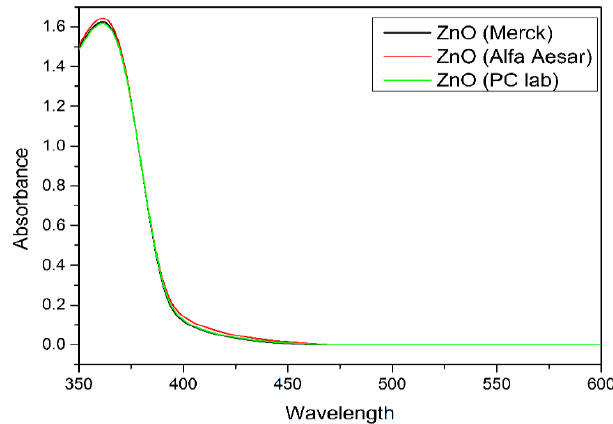
Figure 7. UV-Vis spectra of three different types of ZnO